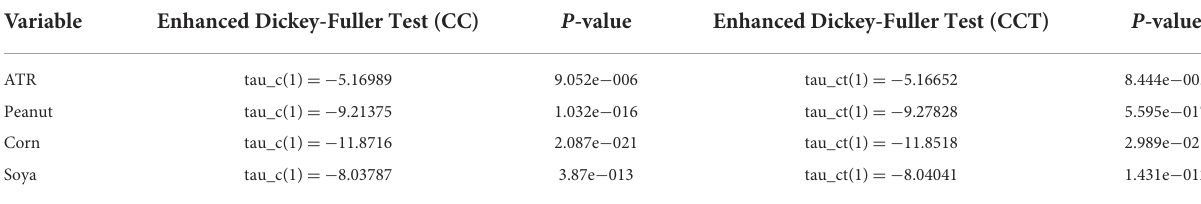
TABLE 2 Results of enhanced Dickey-Fuller Tests, showing the p -value for the studied